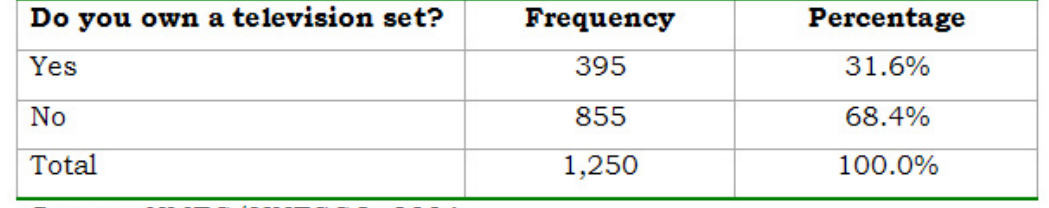
Table 7 above indicates that only 31.6 percent of Nigerians own television sets. The percentage of those without television sets is higher due to poverty and low incomes of many Nigerians. This study also reveals that radios are more affordable, and hence attainable, than television